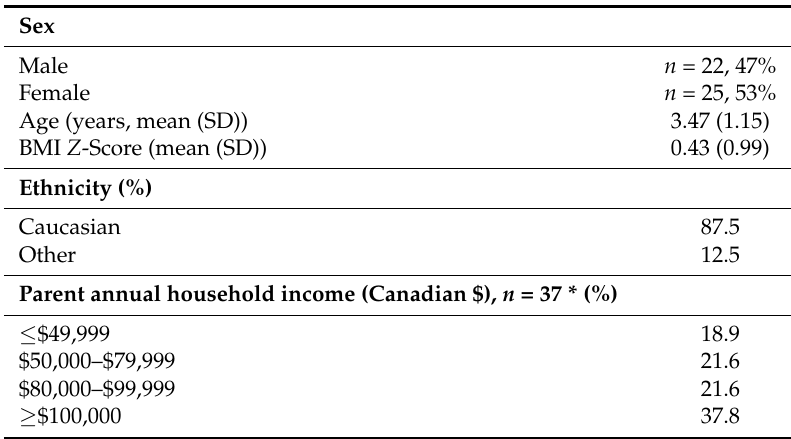
Table 1. Participant Characteristics.